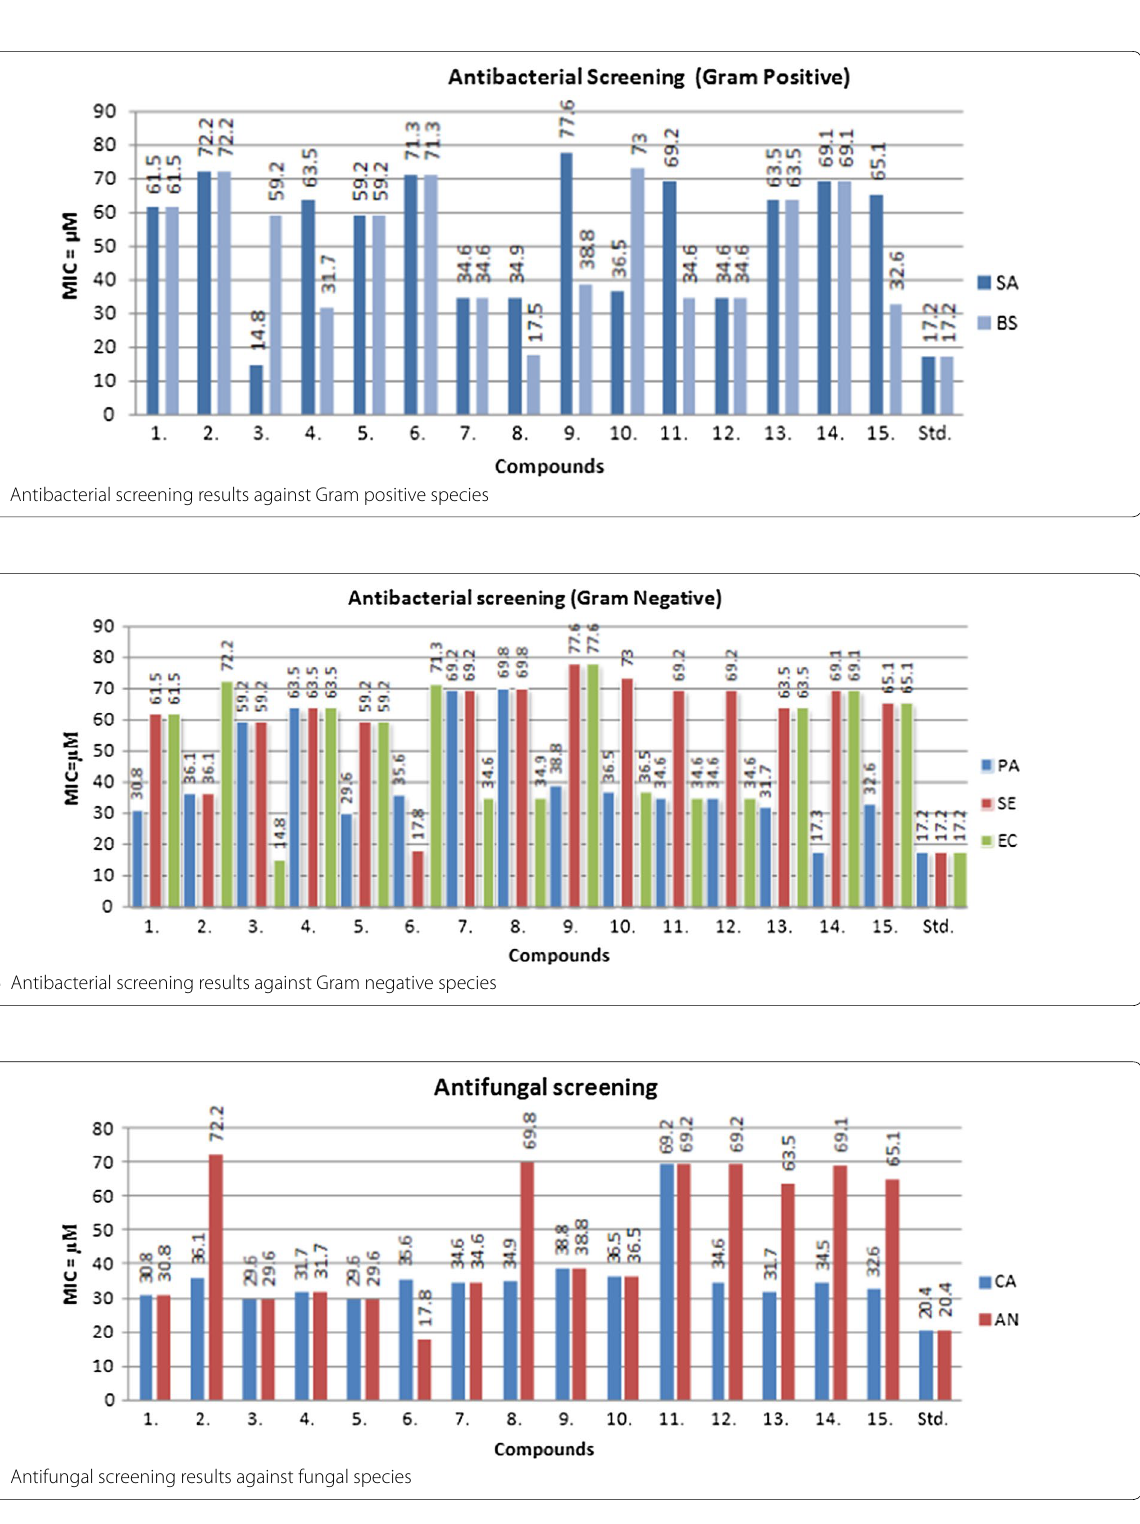
good anticancer activity against cancer cell lines (HCT116 and MCF-7) were displayed good interaction with cru-